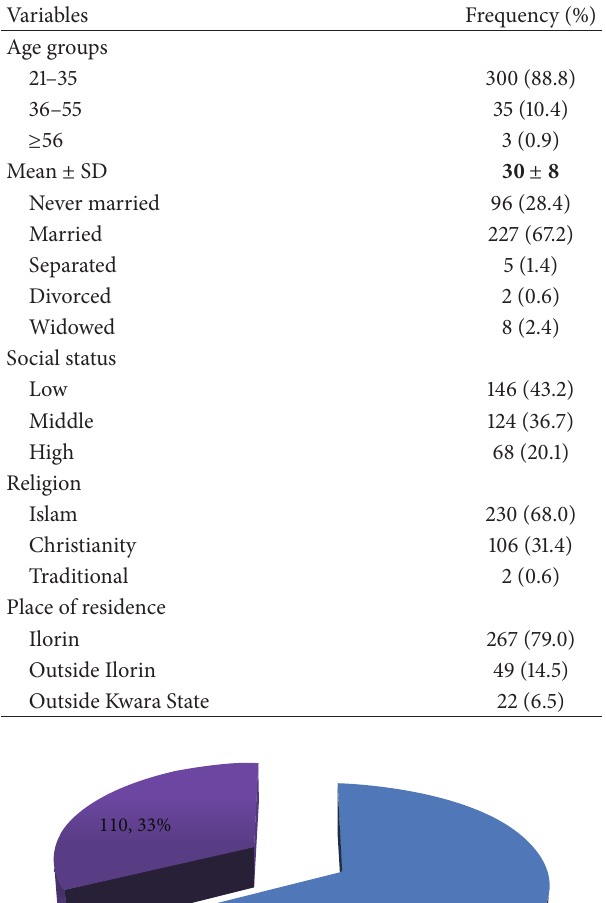
Table 2: Respondents’ awareness, attitude, and uptake of cervical cancer